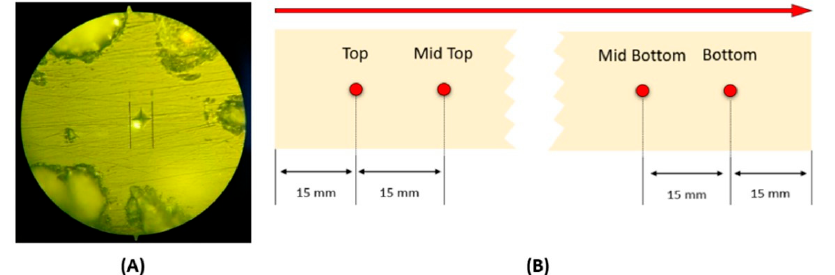
Figure 5. Microhardness test procedure. ( A ) Example of Vickers indentation on a specimen. ( B ) Location of hardness measurements.